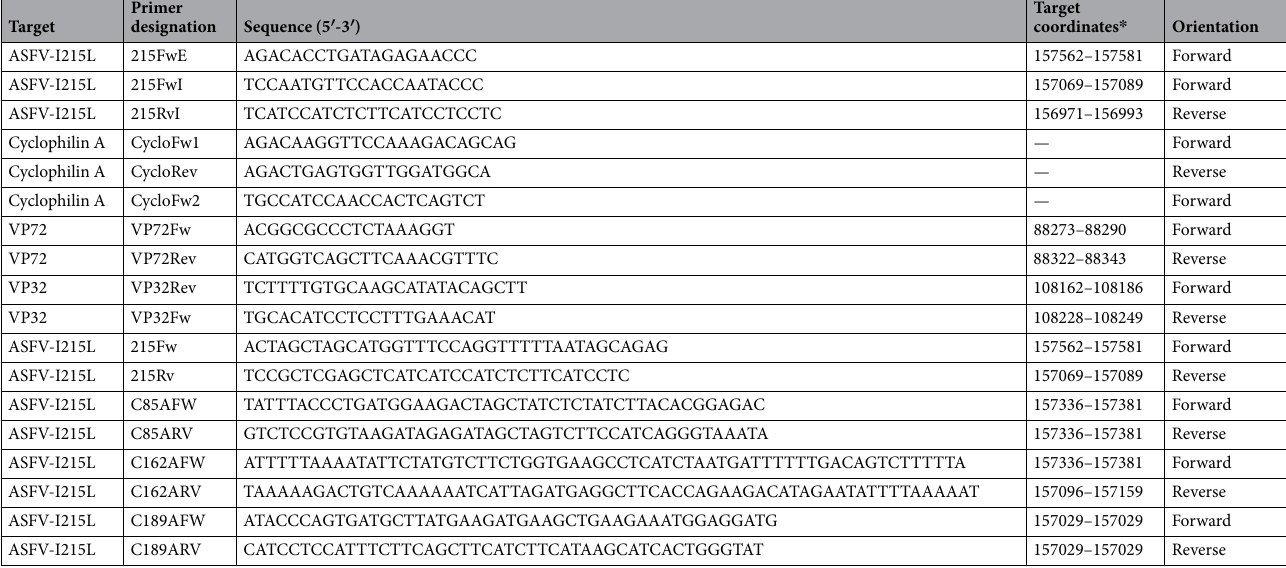
Table 1. Primers used in the present study. * Primer coordinates are relative to Ba71V sequence used has template for primer